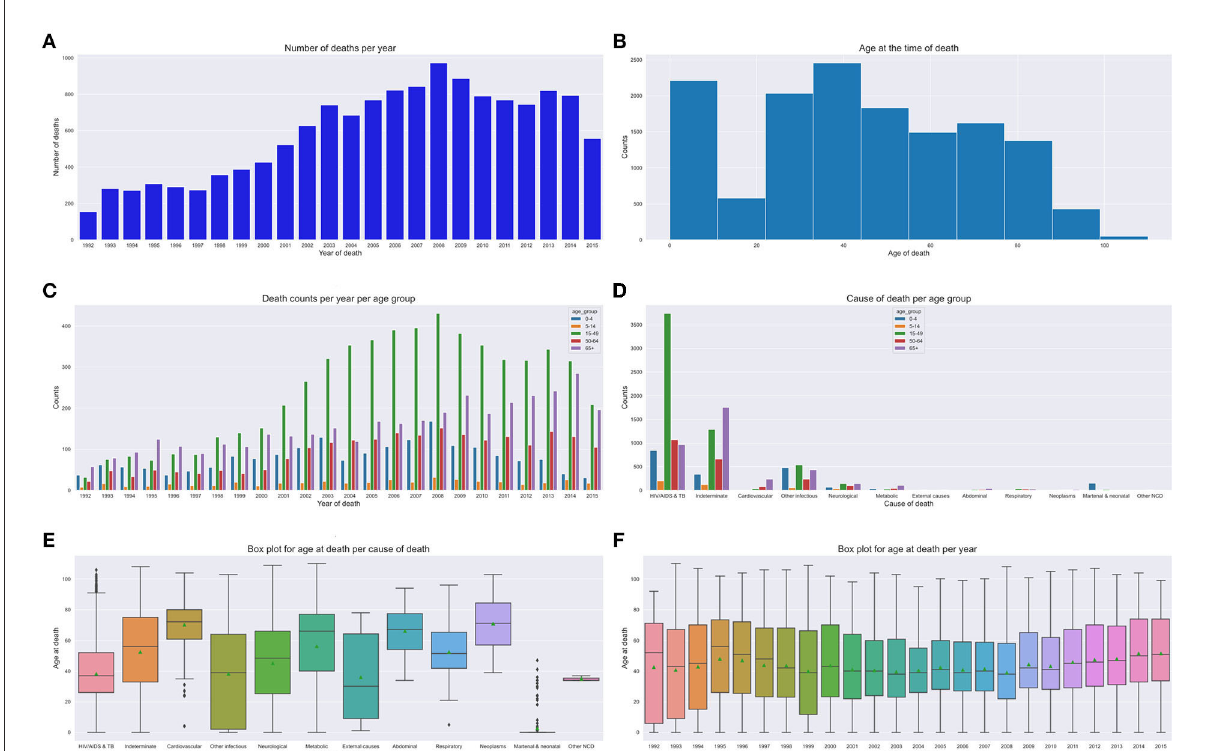
Figure 4C shows mortality trends based on gender over